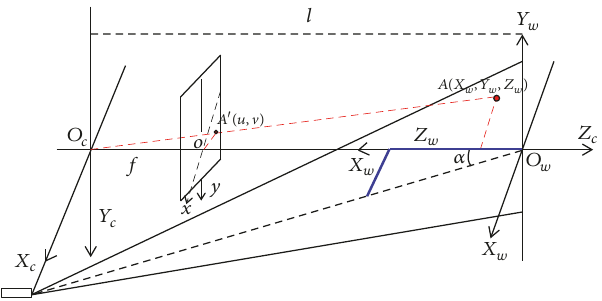
Figure 1: Dimensional reconstruction of structured